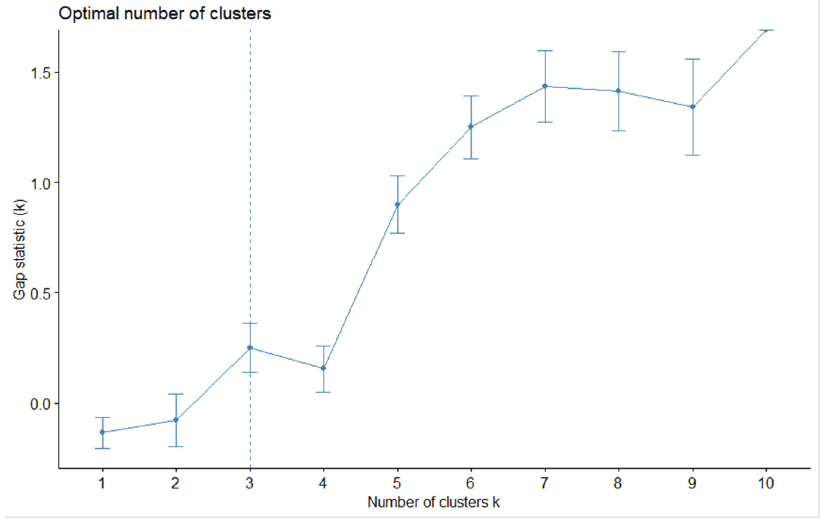
Figure 3. Results of applying the “wss” method to the data.